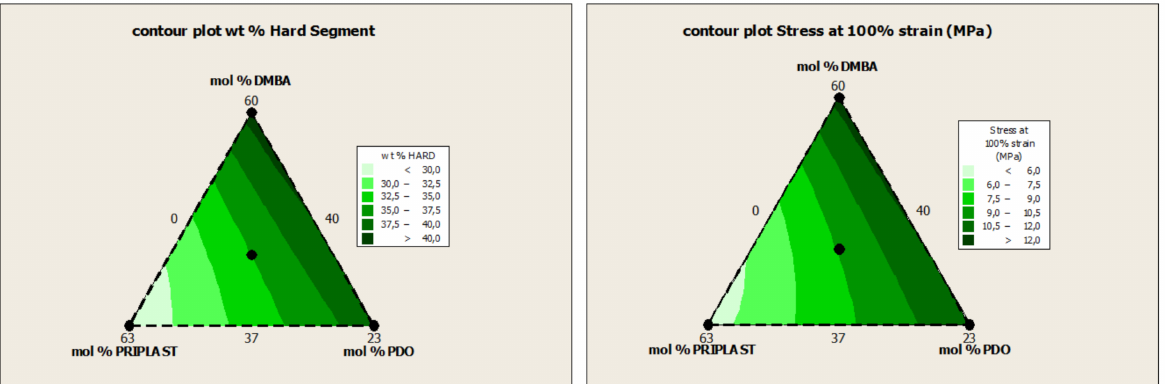
Figure 13. Contour plots obtained by Minitab software from the ternary mixture experimental design. ( Left ): contour plot of Hard segment content in wt. %. ( Right ): contour plot of σ 100% (stress at 100%